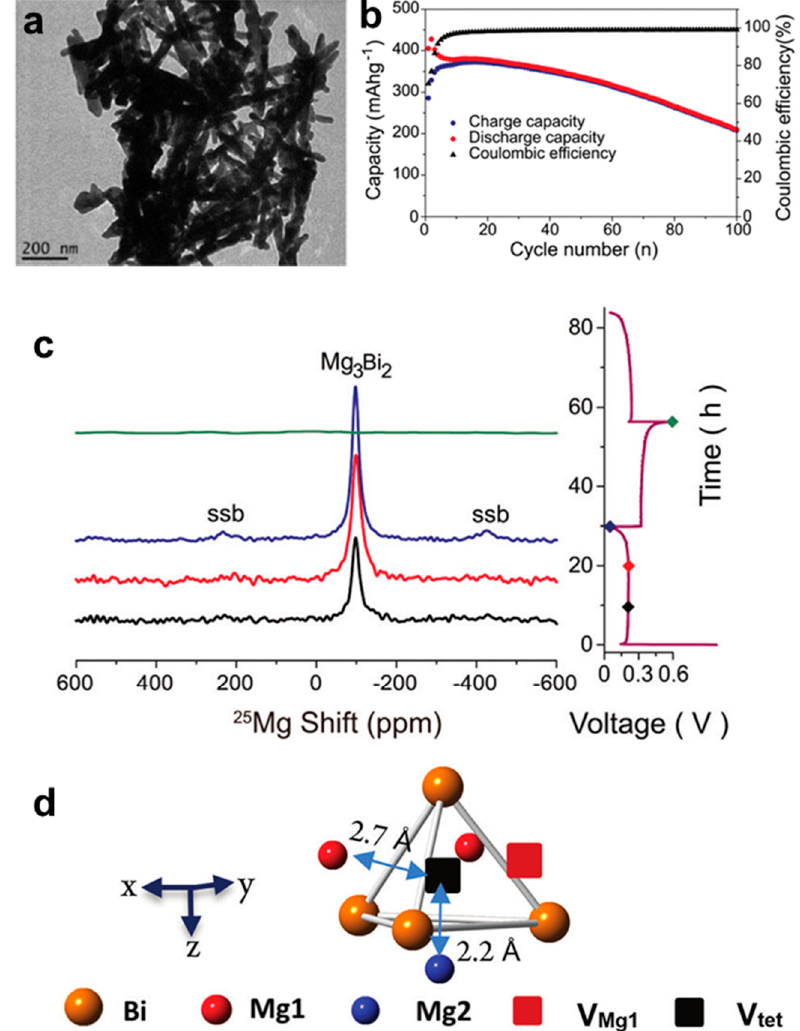
Figure 4. ( a ) TEM image of the Bi nanowires. ( b ) Cycling stability of the Bi nanowire anodes at C/2 rate. ( c ) Quantitative 25 Mg NMR spectra of Bi anode at various states of charge (with color corresponding to the points shown on the electrochemistry profile in the right) at a spinning rate of 14 kHz. Spinning sidebands labeled in the spectra as ssb. ( d ) Schematic structure of Mg 3 Bi 2 with V oct (red square) and V tet (black square). Reproduced with permission [27]. Copyright 2017, The Royal Society of